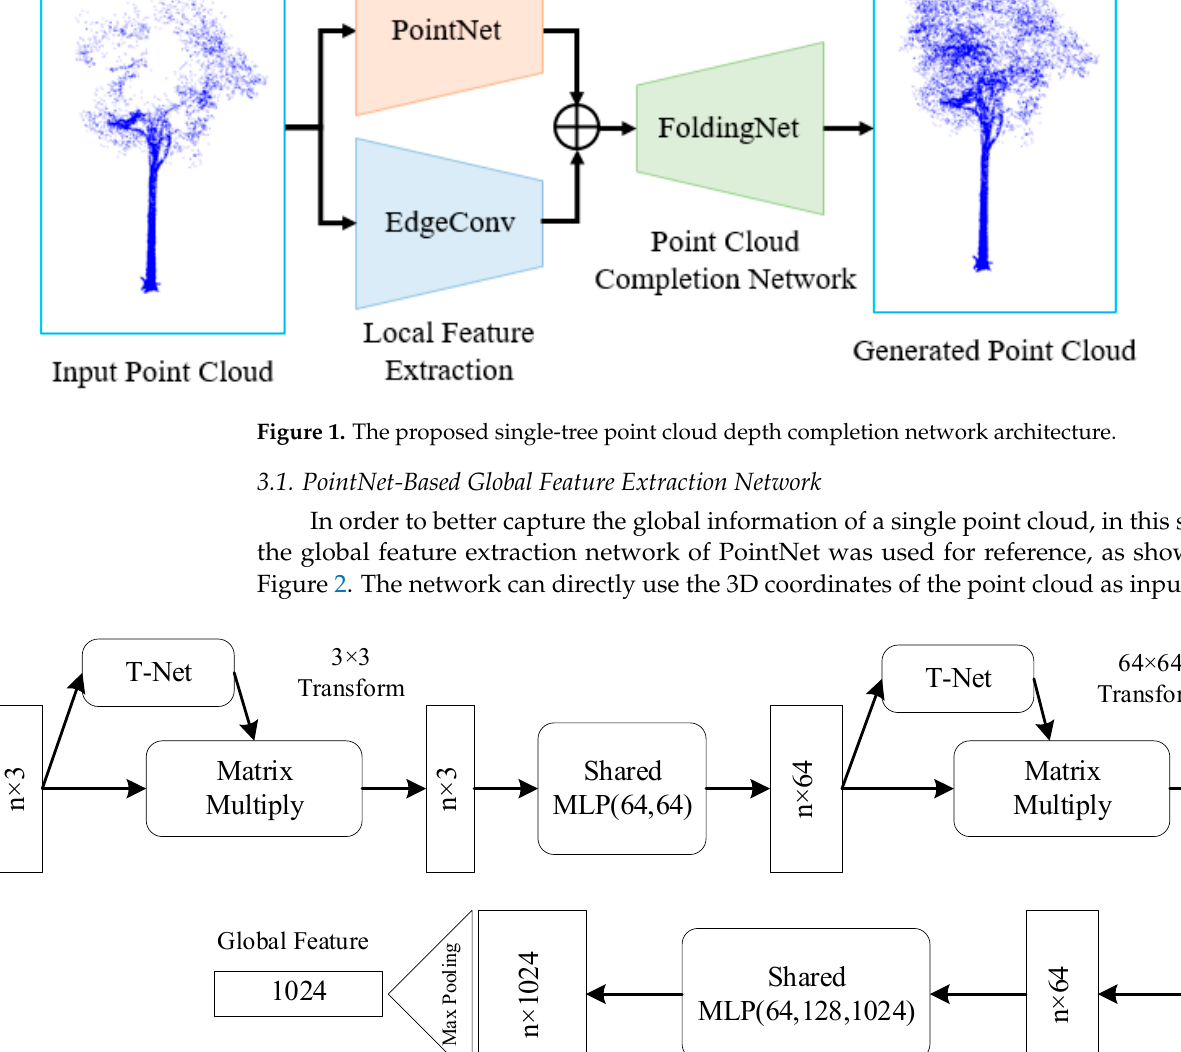
Figure 2. Global feature extraction network architecture.